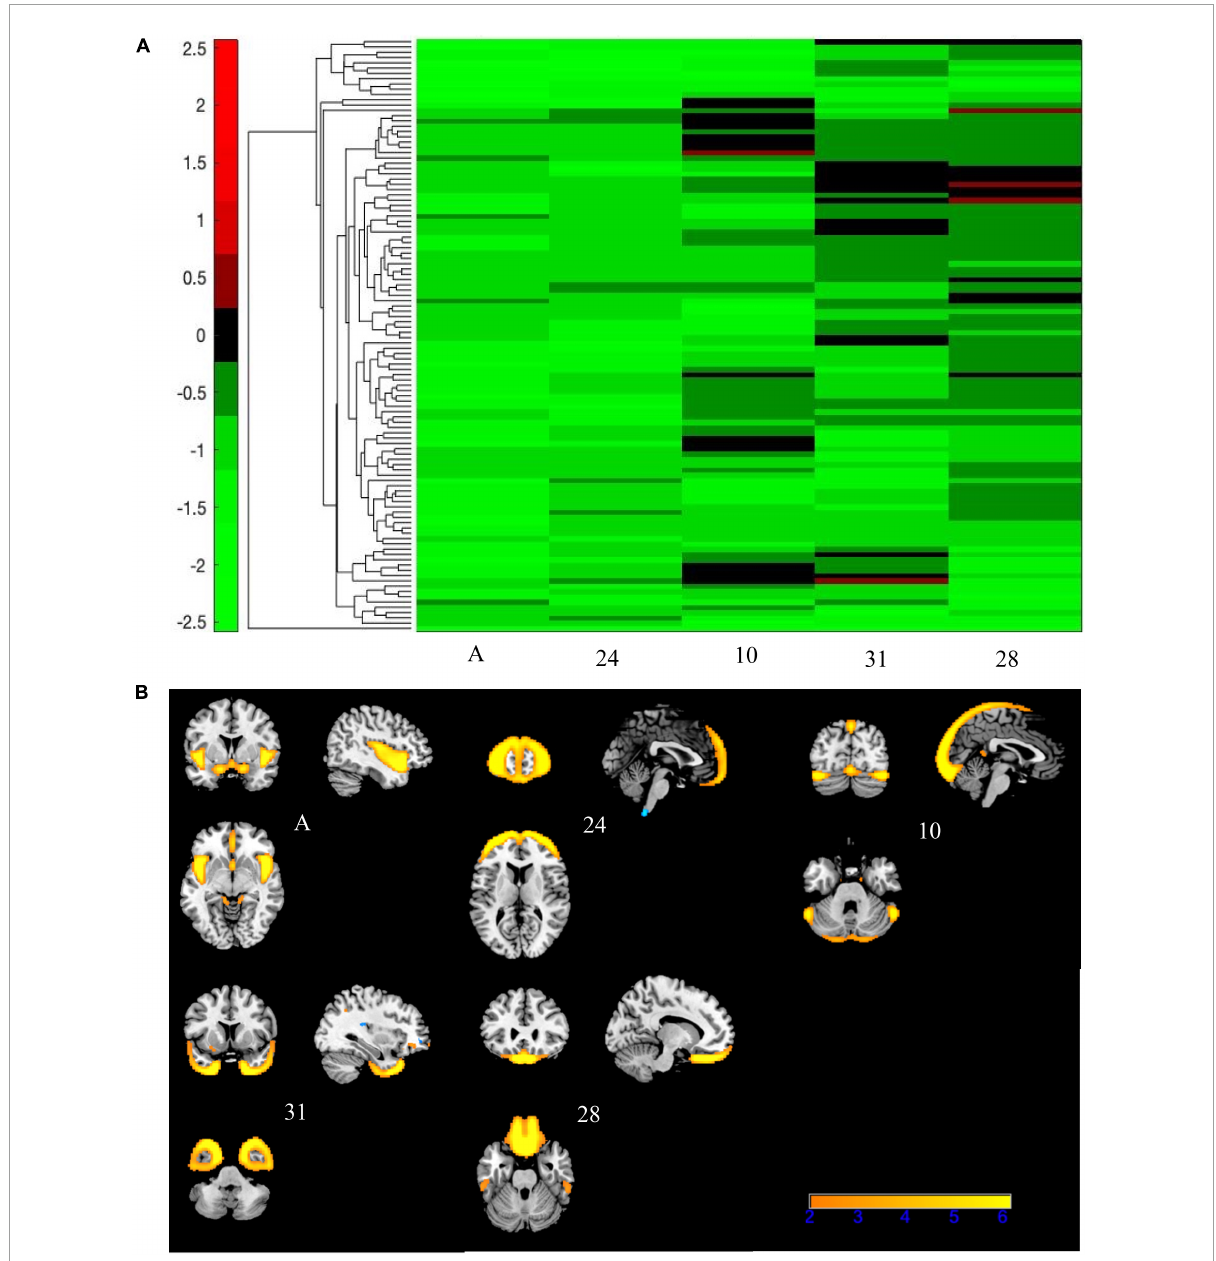
FIGURE8 Bicluster 3: heat map of loadings of independent component analysis (ICA) components and related ICA components. Bicluster C ( N = 112) was comprised of five ICA components (A, 24, 10, 31, and 28) shown above that had mostly negative loading coefficients (A) . There were no PANSS subscales associated with bicluster C. Images in (B) 8B are thresholded at |2.5|. Warm colors represent positive